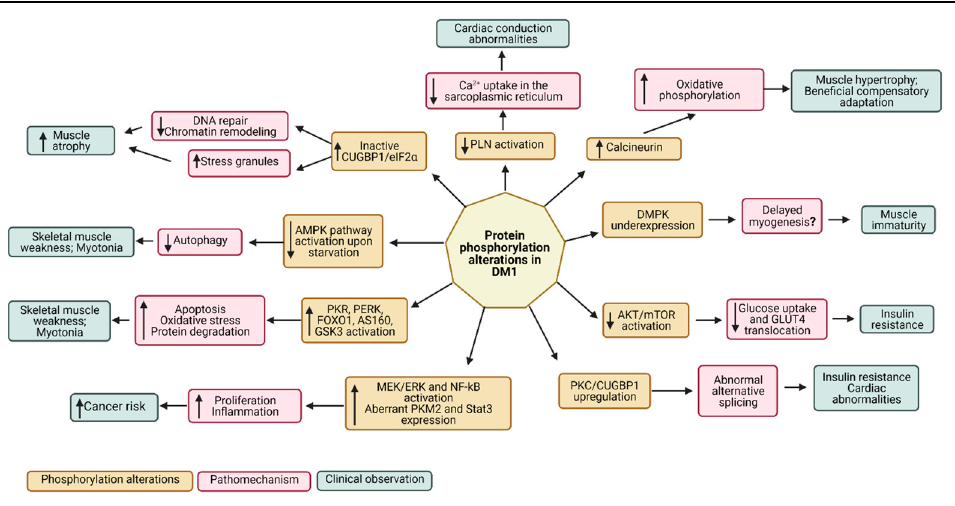
Figure 6. Schematic representation of the major protein phosphorylation and molecular alterations in DM1, corresponding pathomechanisms, and clinical manifestations. Created using Biorender.com. Symbols: ↑, increased ; ↓, decreased .